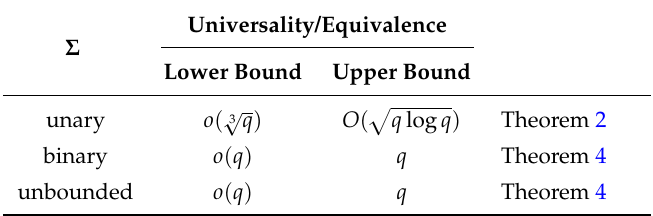
Table 1. Universality/Equivalence; functions refer to exponents of bounding functions.